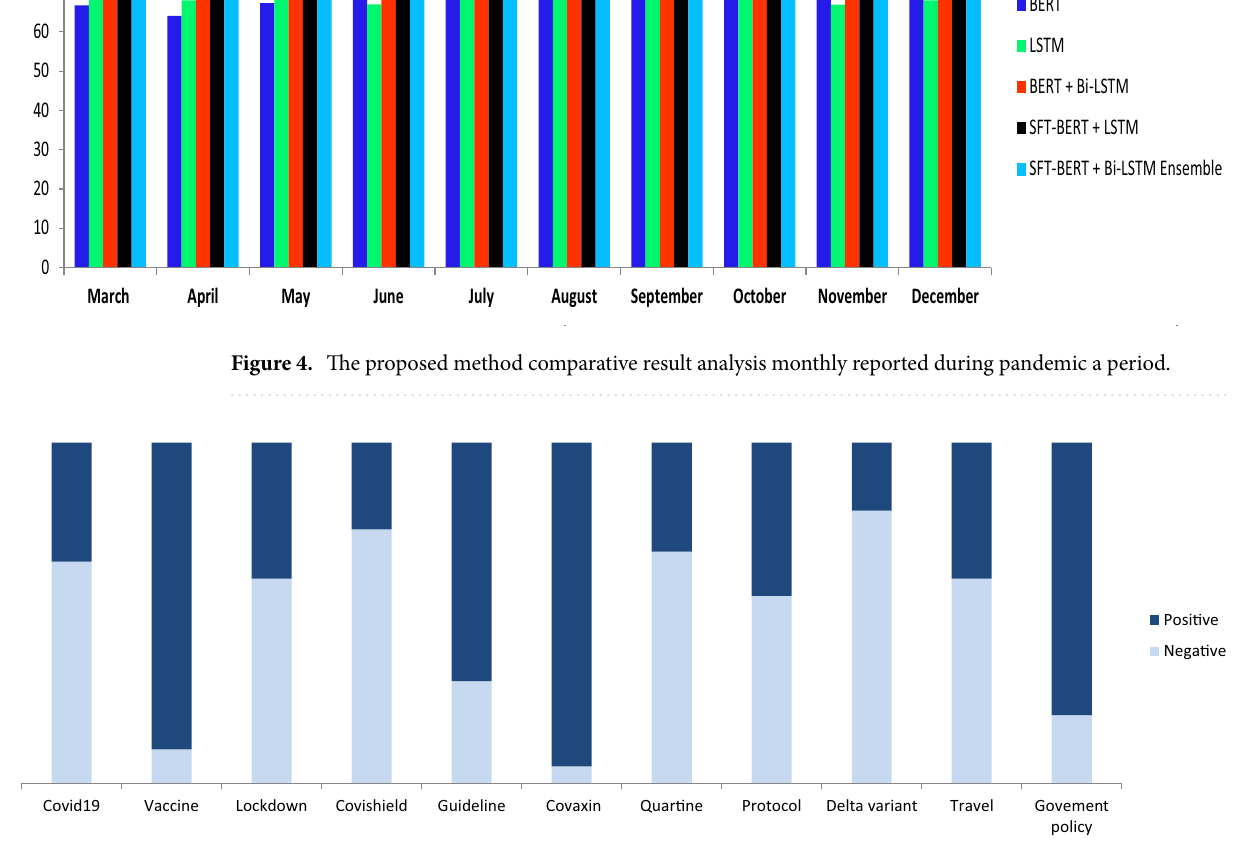
Figure 5. Overall public sentiment classification on various aspects discussed during the pandemic period.